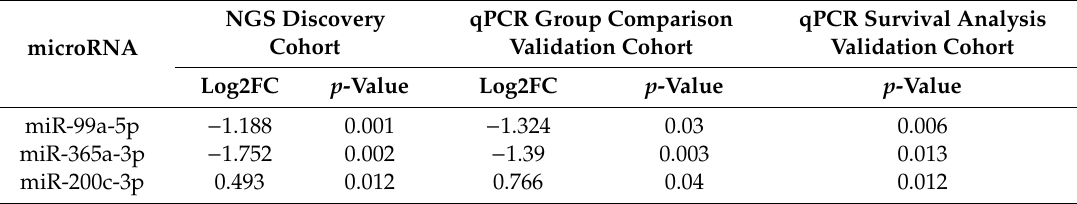
Table 3. Results of the validation of miRNA candidates by qPCR in the independent cohort of PDAC patients.